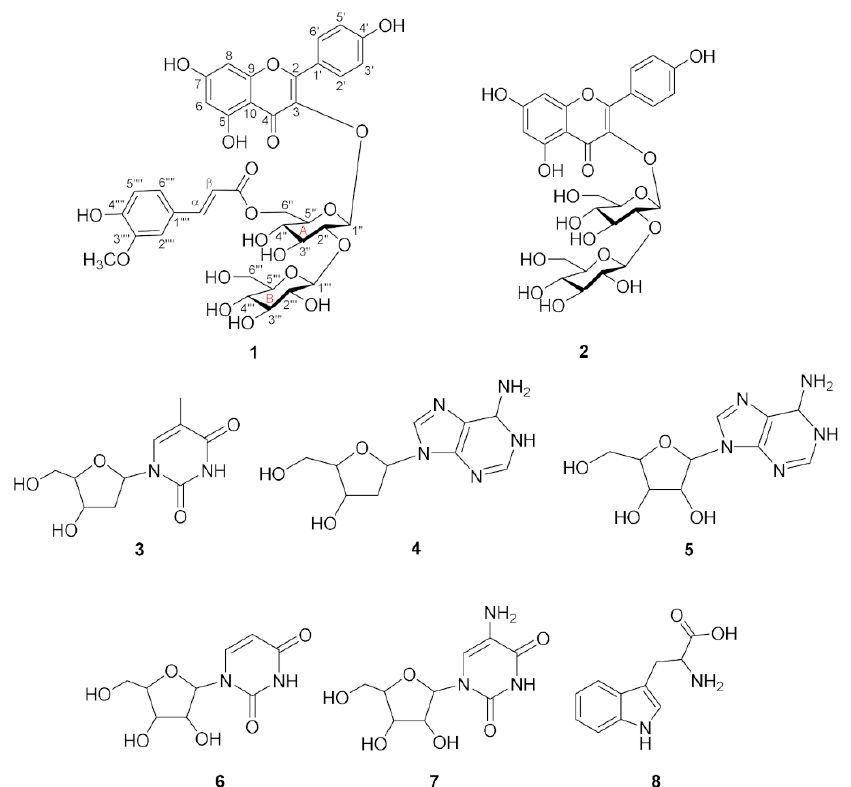
Figure 4. Chemical structures of compounds 1 − 8 . 1 , kaempferol-3- O -(6 (cid:48)(cid:48) -feruloyl)-sophoroside; 2 , kaempferol-3- O -sophoroside; 3 , thymidine; 4 , 2 (cid:48) -deoxyadenosine; 5 , adenosine; 6 , uridine; 7 , 5-aminouridine; 8 ,